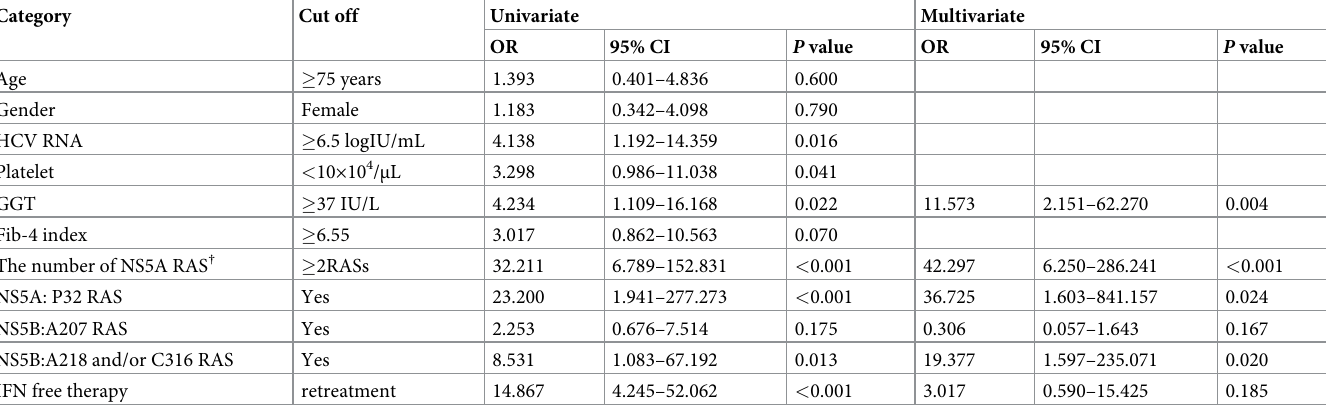
Table 4. The multivariate logistic regression analysis of factors associated with virologic failure in patients treated with sofosbuvir and ledipasvir.